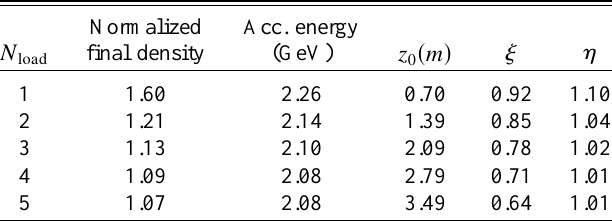
TABLE I. Horn model: tube length (cid:1) 0.35 m. Normalized Acc.